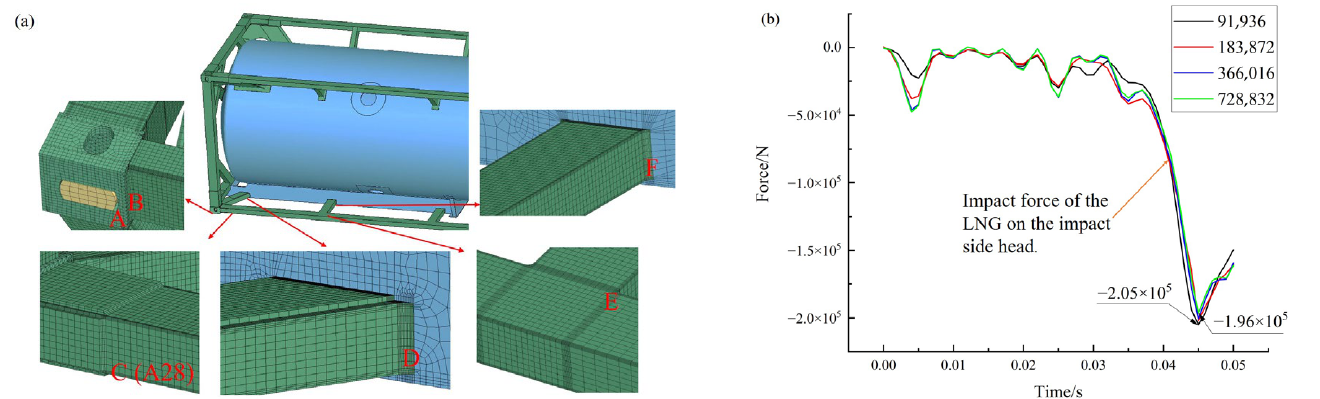
Figure 10. Mesh independence verification: ( a ) frame mesh, ( b ) fluid mesh in the contact region. Only the inner vessel finite element model was built and filled with 50% of the volume of LNG, constraining all of the translational degrees of freedom of the outer surface of the inner vessel, in order to verify the reasonableness of the fluid-solid coupling contact parameters. When the theoretical value of the axial force of LNG on the head is compared to the simulation, the error is only discovered to be 2.2%. After the verification, the contact parameters were decided. The following formula was used to calculate the theoretical value: where p is hydrostatic pressure; s is